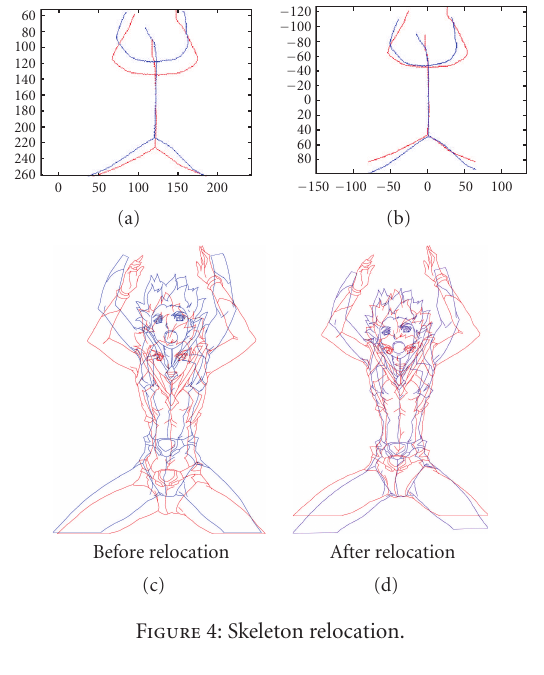
Figure 5: General topology model.